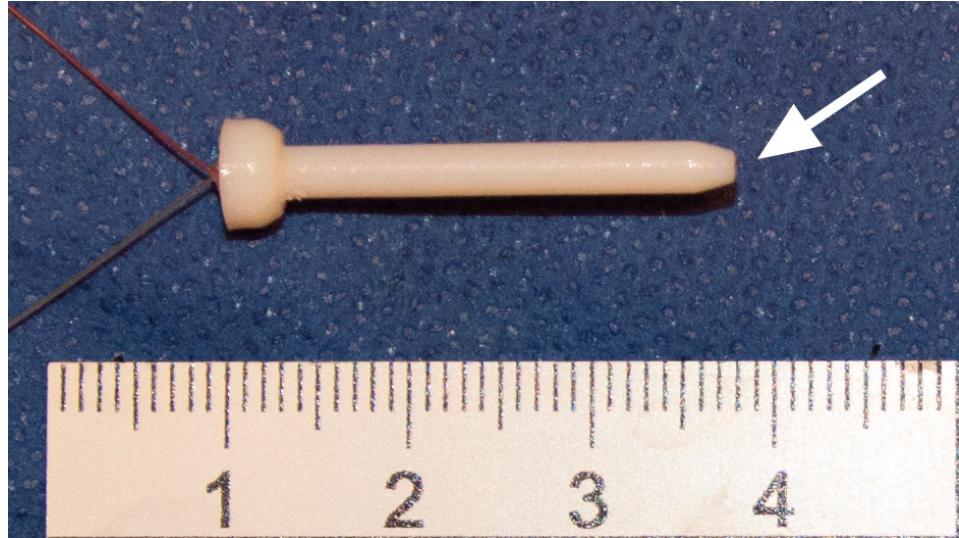
Figure 4. 3D-printed sleeves of VeroWhite with incased thermocouple. The arrow indicates the exposed measuring point of the thermocouple .